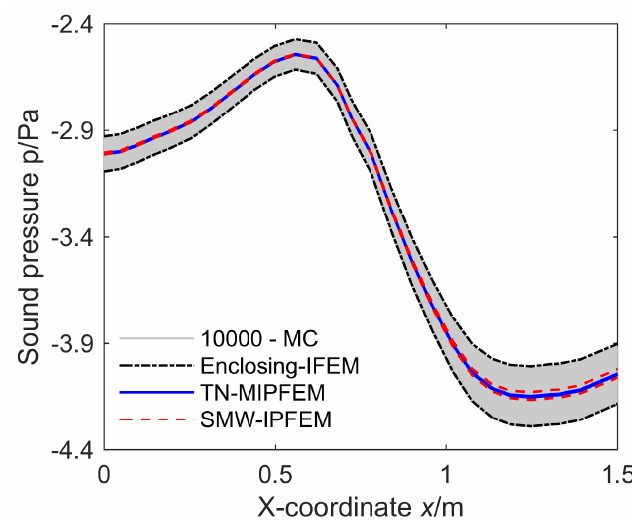
Figure 10. The sound pressure along the bottom-line at frequency 90